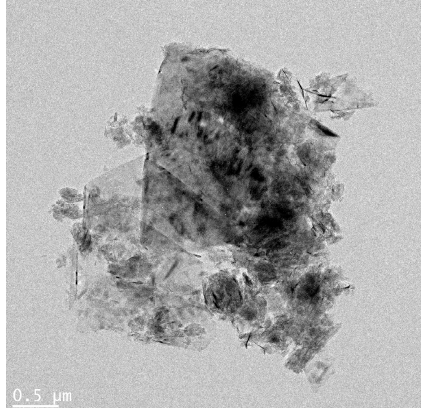
Figure 1. Agglomeration form of graphene nanoplatelets (bar = 0.5 µm).